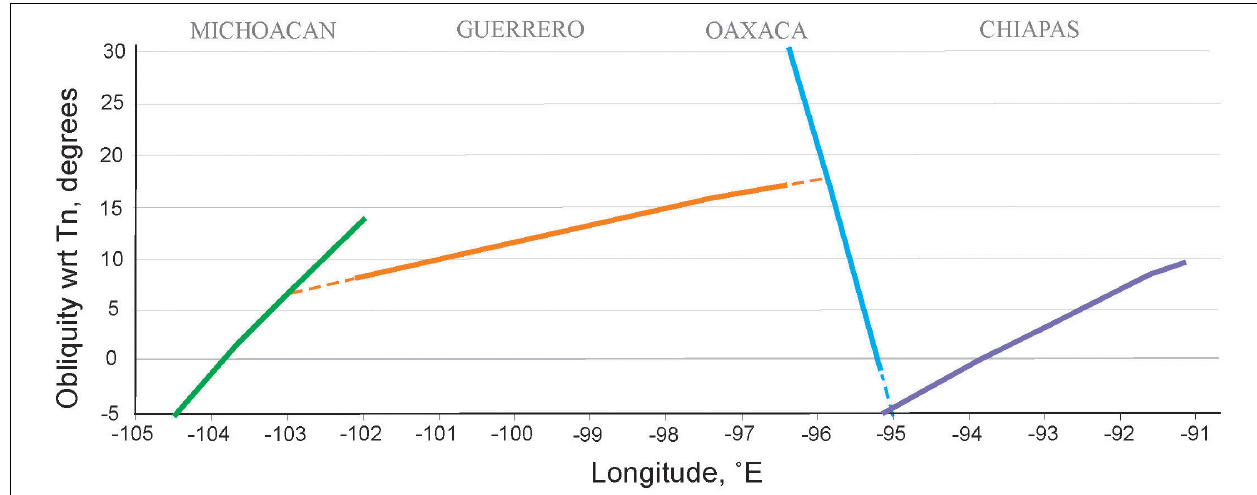
FIGURE 3 | Variation of obliquity angle along the Mexican fragment of the Middle America Trench. The obliquity is relatively higher in the Guerrero–Oaxaca segment of the MAT and low or negative in Michoacan and